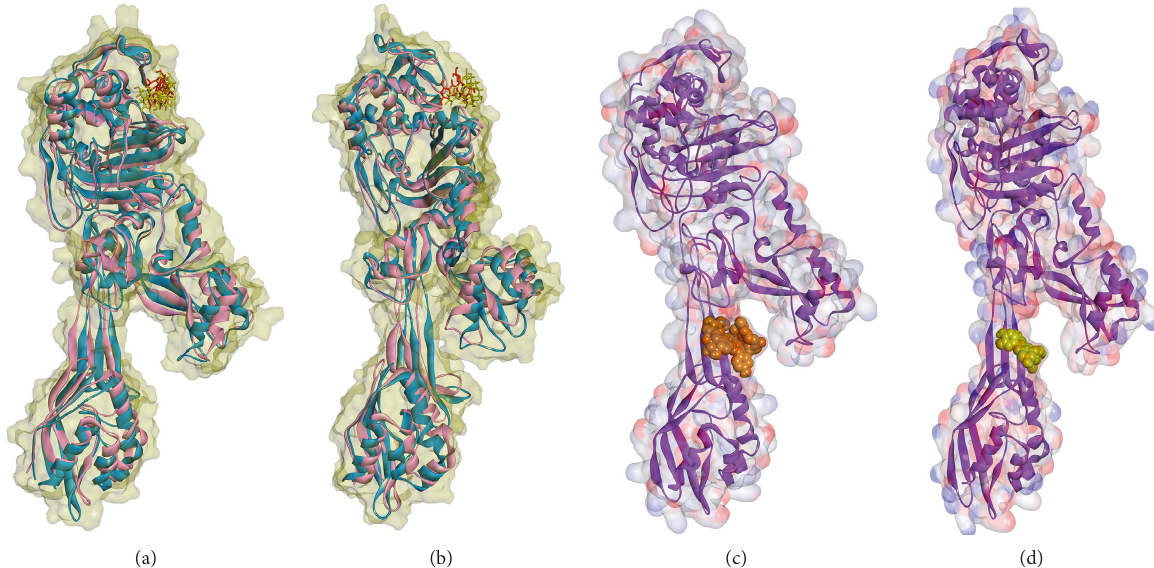
Figure 6: (a)-(b) Docking analyses with the active site of SauPBP2a: superimposed structures of SauPBP2a complexed with (a) kaempferol 3-rutinoside-7-sophoroside and (b) rutin before MD simulations (blue chains) and after MD simulations (pink chains). Red and yellow colors represent ligands before and after MD simulations, respectively. Docking models of SauPBP2a allosteric site with (c) kaempferol 3- rutinoside-7-sophoroside and (d) rutin in CPK mode.